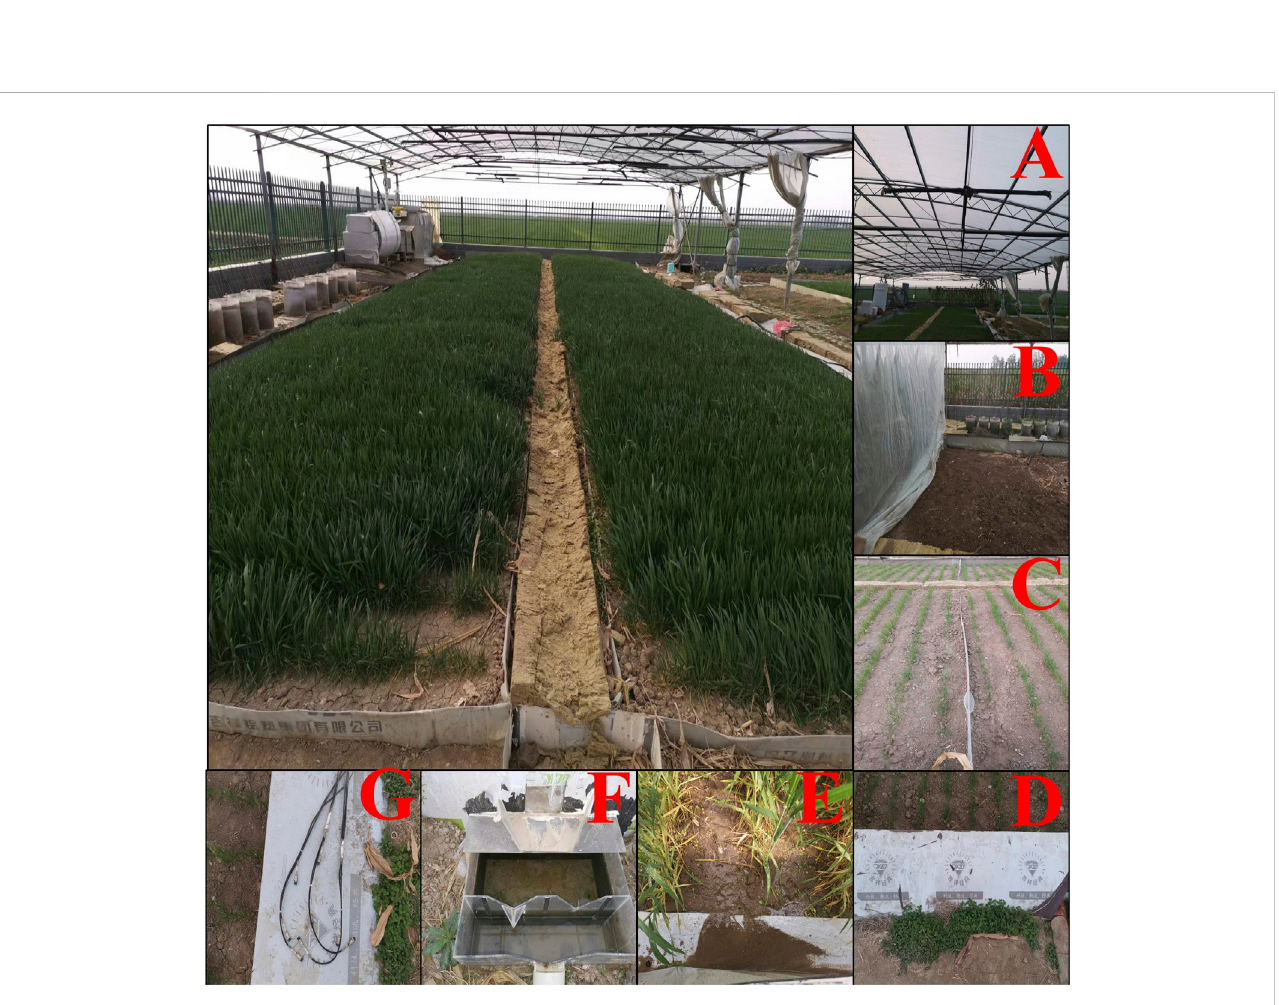
FIGURE 3 Theexperimentalplotanditscomposition.[Figure (A – G) representthecompositionofthewholeexperimentalgroup,itincludesarti fi cialrainfalldevices (A) , wind dodge (B) , water-stop sheep (C) , rain trap (D) , runoff canal (E) , water tank (F) and moisture sensor (G)